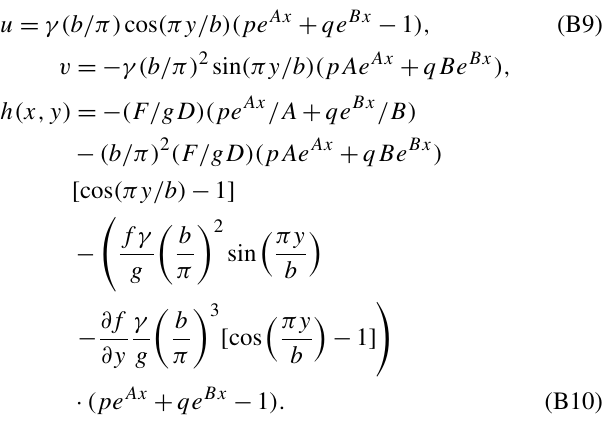
B3 Rotating ocean: f = f 0 + βy Here, the Coriolis force varies linearly with latitude, i.e., f 0 = 2 . 5 × 10 − 4 , β = 10 − 10